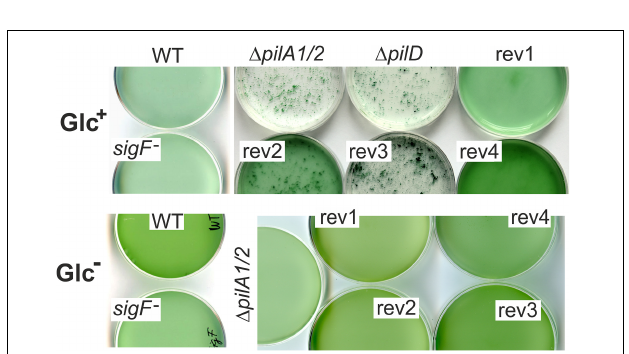
FIGURE 3 | Aggregation of pilin-less cells and (cid:49) pilD suppressor strains. Cell cultures were cultivated in Erlenmeyer flasks on a rotary shaker at 120 rpm in mixotrophic (Glc + ) and photoautotrophic (Glc − ) conditions and then poured into Petri dishes and photographed at a similar optical density (730 nm).